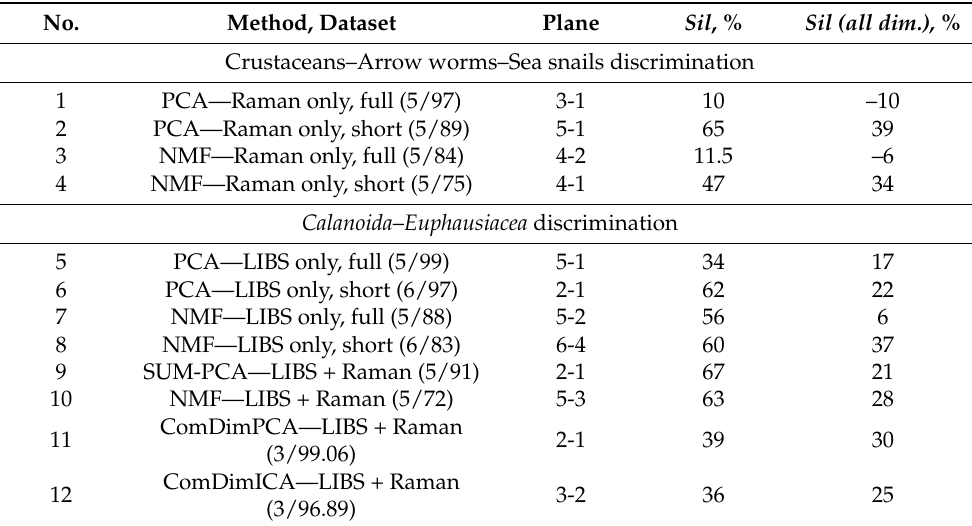
Table 1. Silhouettes (in %) for all the score graphs involved in the present study. No. Method, Dataset Plane Sil , % Sil (all dim.), % Crustaceans–Arrow worms–Sea snails